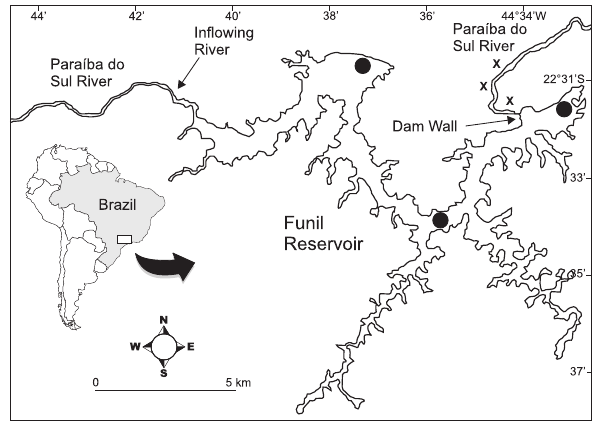
Figure 1. Study area, Funil Reservoir and the main inflowing river (Paraíba do Sul River), indications of the sampling sites in the res- ervoir (  ) and in the stretch downriver of the reservoir ( 